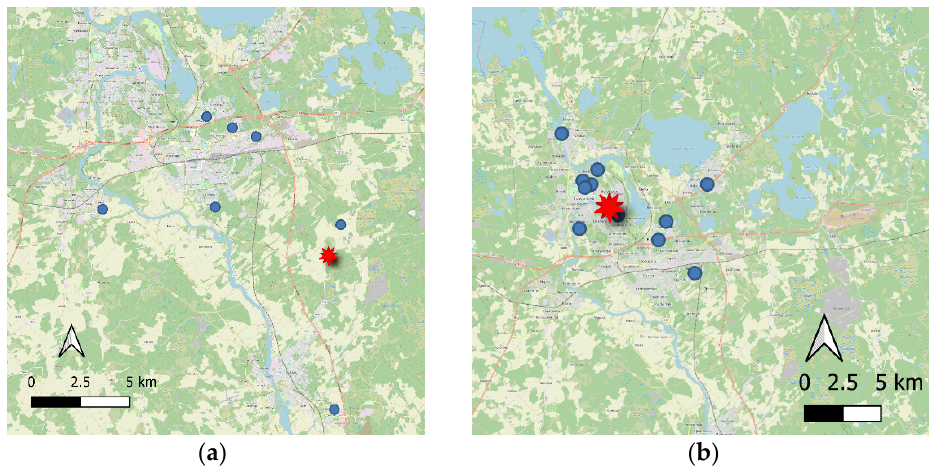
Figure 4. Locations of macroseismic reports related to the earthquake in: ( a ) Anjalankoski on 10 May 2003 at 00:18 local time, M L 1.8; ( b ) Kouvola on 27 February 2012 at 06:04 local time, M L 1.3. The red stars show the epicenters and the blue dots the origins of the macroseismic reports.